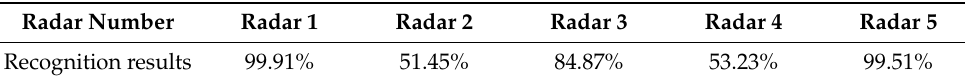
Table 3. Recognition accuracy for